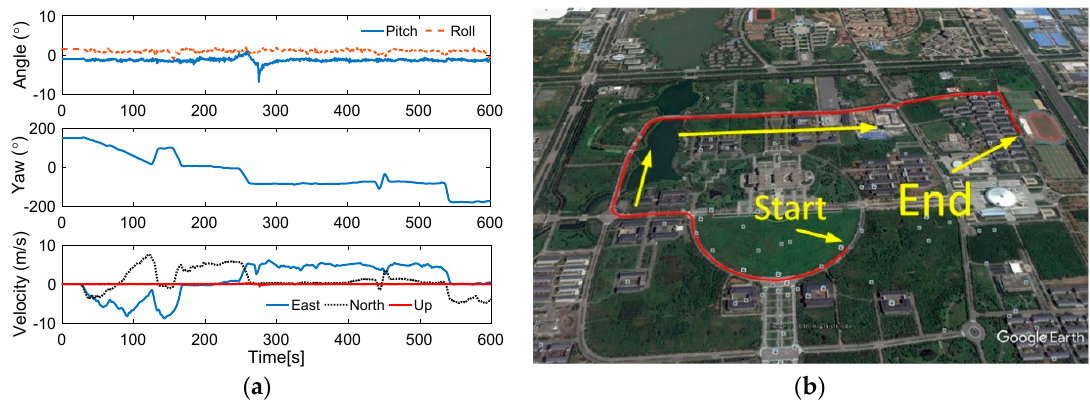
Figure 17. ( a ) Curves of vehicle motion; and ( b ) trajectory of vehicle motion.